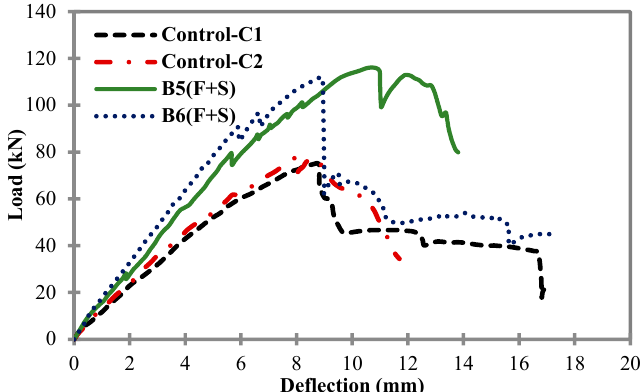
Figure 8. Load vs mid-span deflection for control samples C1 and C2, and B5 and B6. Figure 8. Load vs. mid-span deflection for control samples C1 and C2, and B5 and